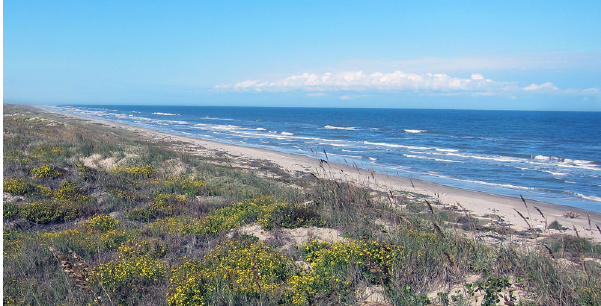
Fig. 1 What is the coastal white ribbon? The coastal white ribbon spans the transition between land and sea; it is herein de fi ned as the nearshore shallow water region below which there exists a paucity of data constraining deep structure and processes. The image shows breaking waves resembling a white ribbon in the nearshore zone at Padre Island National Seashore, Texas, USA (Photo credit: B. Weymer. 29 November,